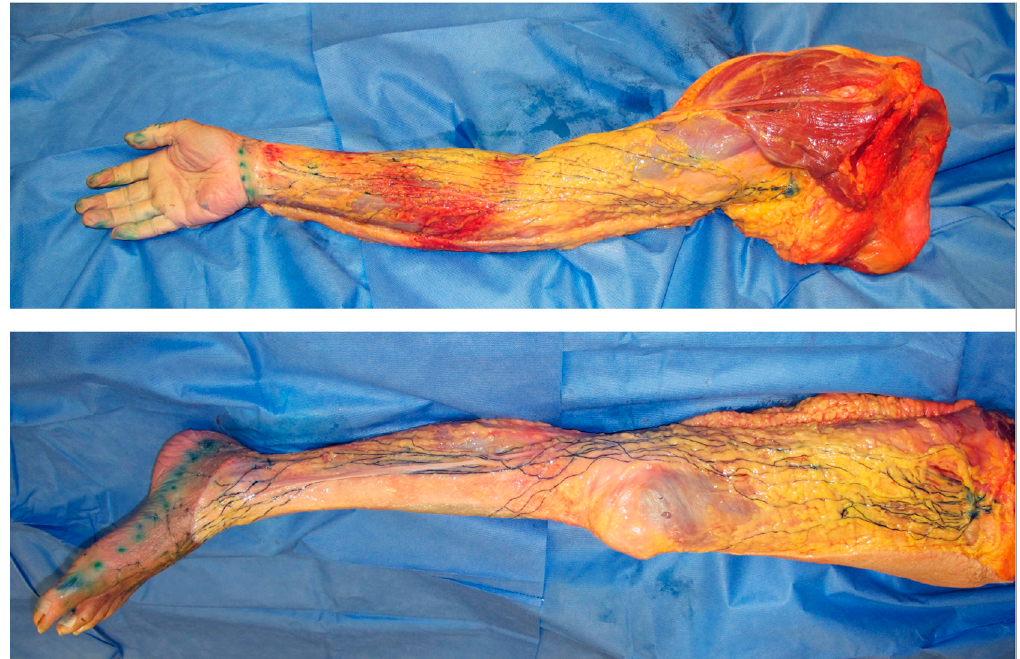
Figure 2. Dissection photos of the superficial lymph-collecting vessels and their corresponding lymph nodes in the upper and lower limbs visualized using the microinjection technique. The lymphatic vessels were injected with blue acrylic dye, and the skin and adipose tissue were removed just above the vessels. Arrows indicate the sentinel node/s of the upper limb (white) and lower limb (black).